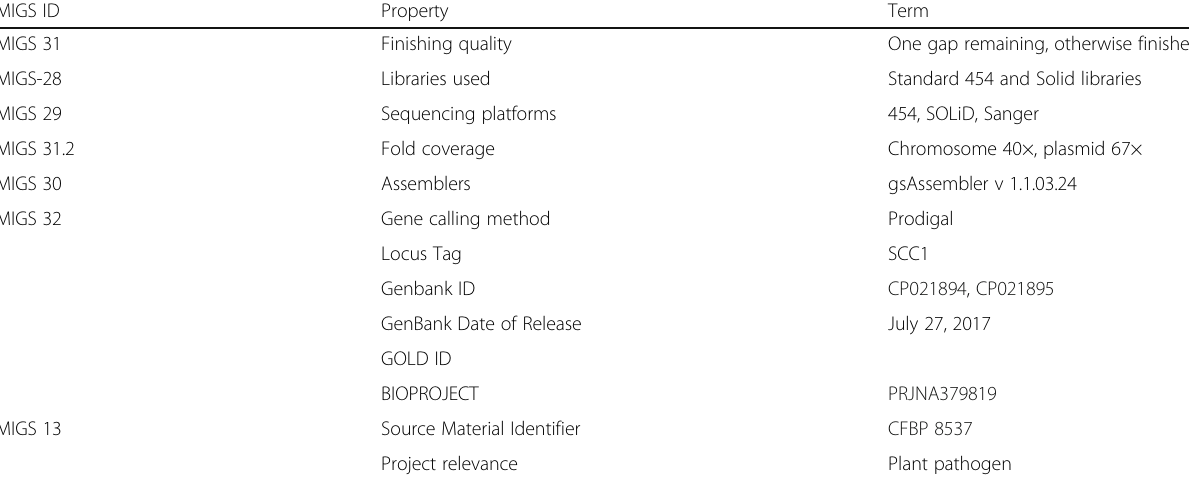
Table 2 Project